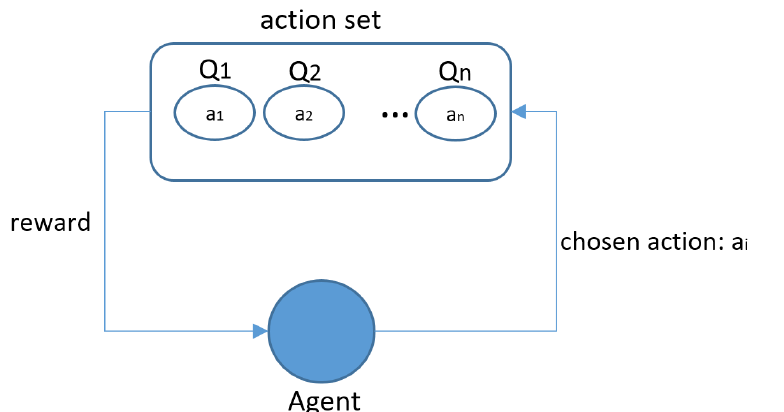
Figure 4. Q-Learning